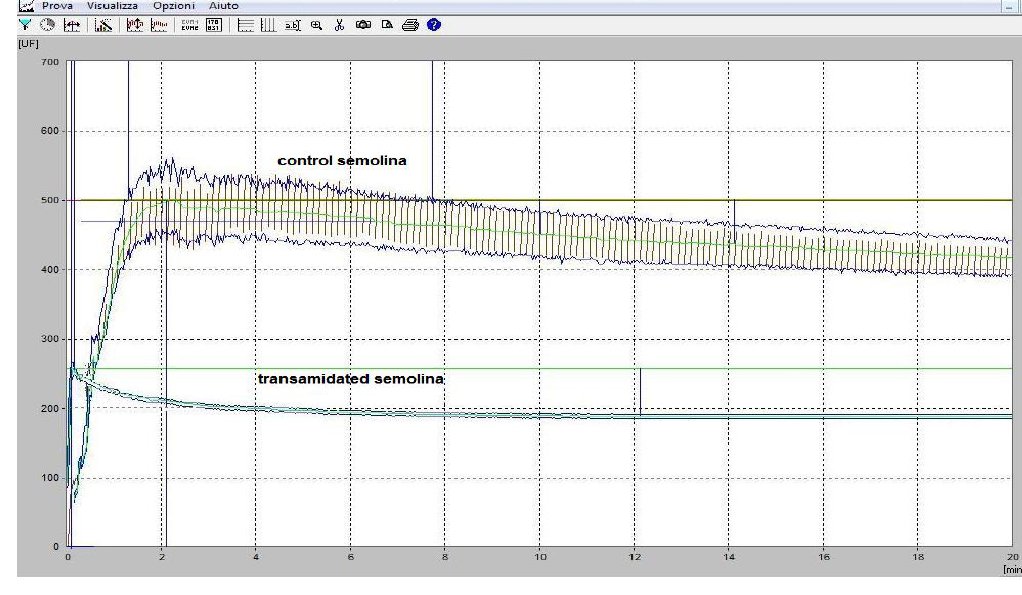
Figure 3. Farinograph profile of control and transamidated semolina.